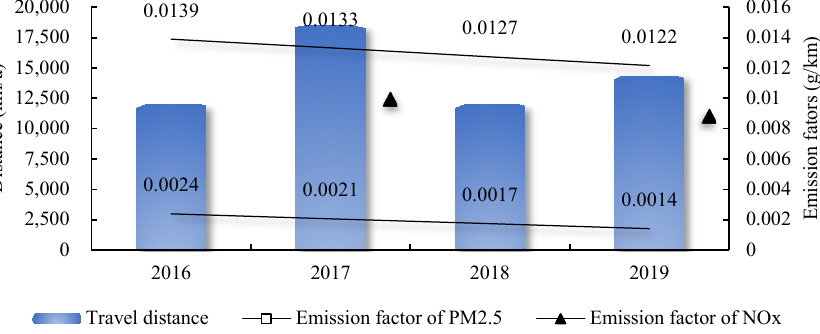
Figure 2. Travel distance and emission factors of LDGVs in Beijing from 2016 to 2019.